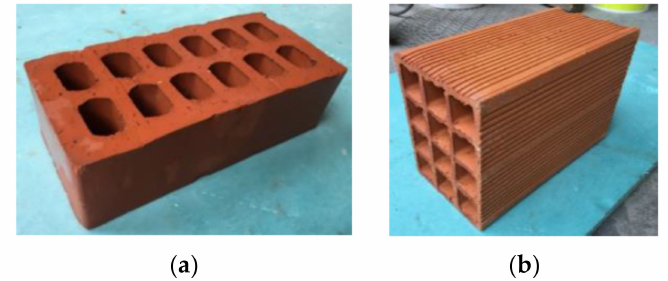
Figure 2. Brick units used for veneer prisms ( a ) and infill prims ( b )